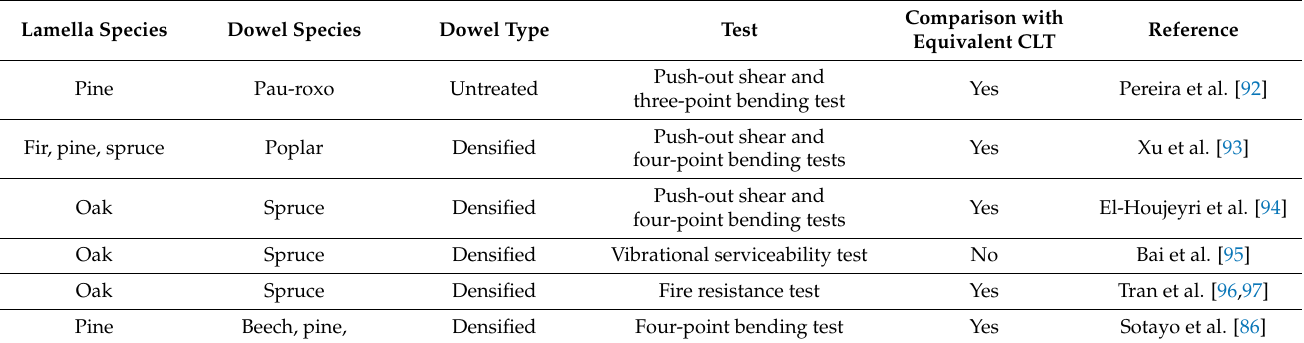
Table 2. Summary of data on dowelled cross-laminated timber